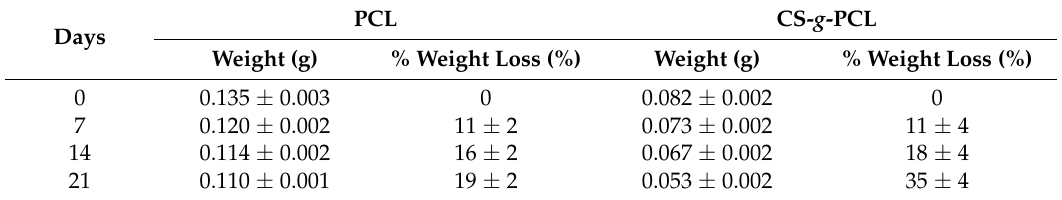
Table 1. Weight loss and % weight loss for PCL and CS- g -PCL in α